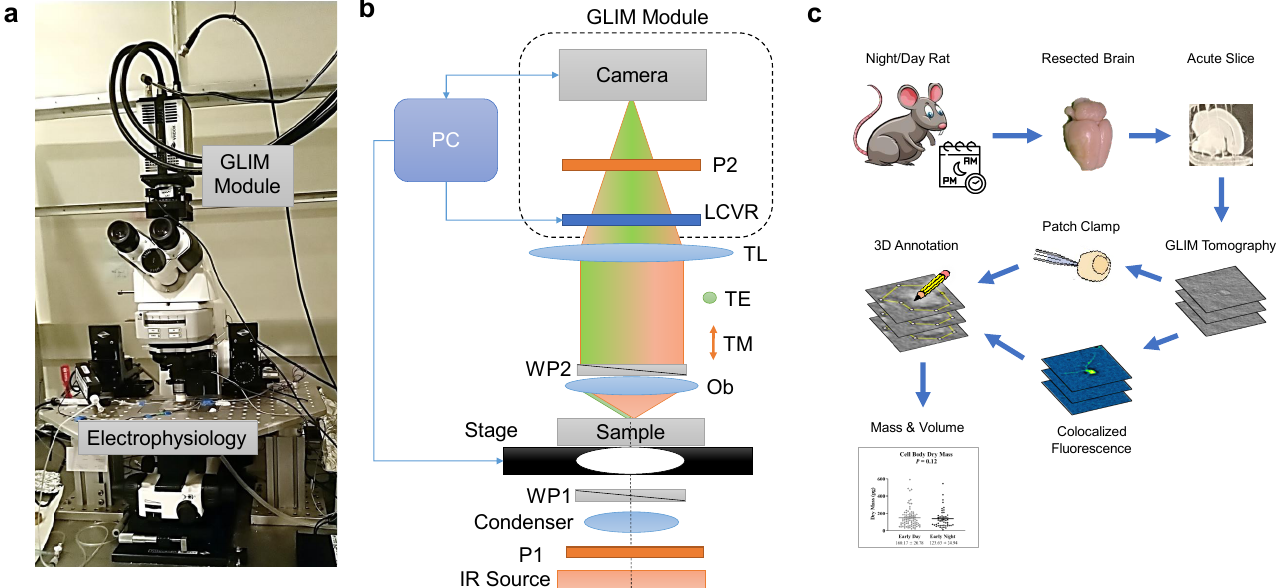
Figure 1. Gradient light interference microscopy and electrophysiology system to characterize acute brain slices. ( a ) Compact GLIM module attached to a motorized microscope equipped with infrared DIC illumination and electrophysiology patch-clamp system. ( b ) Interferometric imaging system. An IR source is uniformly illuminating the sample via a polarized condenser. The Wollaston prism WP1 splits the unpolarized light into TE and TM polarizations, which are slightly shifted at the sample plane. The light scattered from the sample passes through the WP2 such that the two beams are now recombined. The tube lens (TL) forms a magnified image at the camera plane. Before reaching the detector, the liquid crystal variable retarder (LCVR) modulates the phase of one polarization with respect to the other. An output polarizer (P2) projects the orthogonal polarizations to the same direction such that they interfere at the camera plane. A personal computer (PC) synchronizes precisely the LVCR modulation with camera acquisition and stage position. ( c ) GLIM was used to study circadian changes in astrocyte dry mass and morphology. Acute brain slices were harvested from rats during the day or night portion of the cycle. GLIM tomography was performed followed by patch clamp and fluorescence confirmation of astrocytes. Data were annotated using a 3D